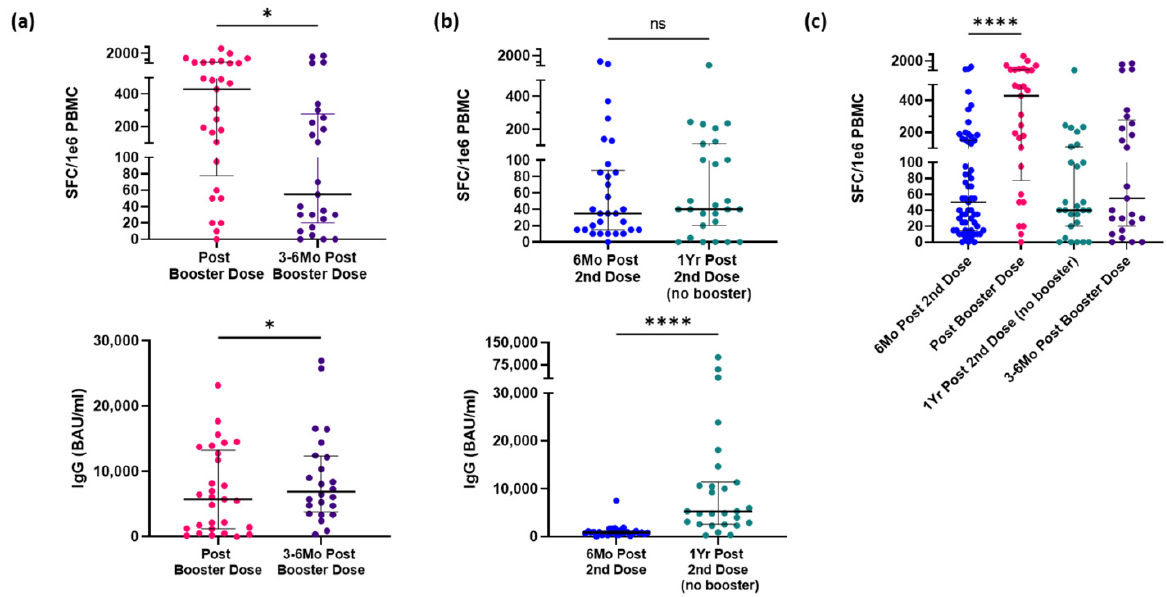
Figure 4. Strong effects of booster wane over time, but not below pre-boosted levels. ( a ) Spike-specific CD4 + T-cell (above) and IgG antibody (below) within 2 weeks after participants received a third dose and 3 to 6 months follow-up ( n = 29). ( b ) Spike-specific CD4 + T-cell (above) and IgG antibody (below) within 6 months after participants received last dose of vaccine 1-year follow-up ( n = 31). ( c ) A summary of spike-specific CD4 + T-cell response from participants’ baseline within 6 months of final dose of initial vaccine regimen, response following a third dose (if applicable), and follow-up response 6 months after baseline (no booster) or 3 to 6 months after a third dose. Wilcoxon signed-rank test ( a , b ) or Kruskal – Wallis test ( c ) were used for group comparisons. Middle black bar represents median with outer bars representing interquartile range. Comparisons not significant unless otherwise shown. Abbreviations: SFC, spot forming cells; IgG, immunoglobulin G; BAU, binding antibody units; NS, no significance. * p < 0.05, **** p < 0.0001